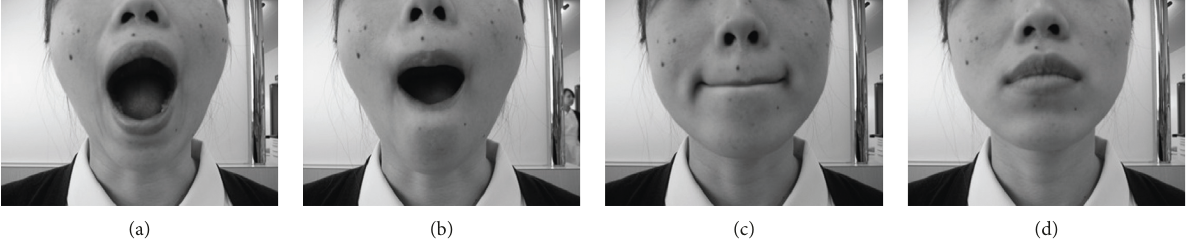
Figure 2: Mouth exercise and relaxation. (a) Take a breath with the mouth wide open. (b) Roll the lips back inside the mouth. (c) Close the mouth until the lips touch. (d) Relax the masticatory muscles, tongue, and jaw without letting the teeth